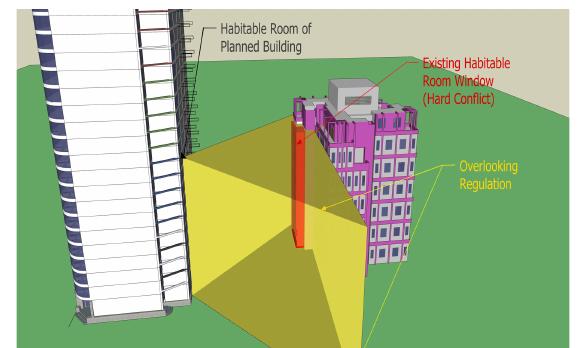
Figure 5. Overlooking regulation conflict (in RED